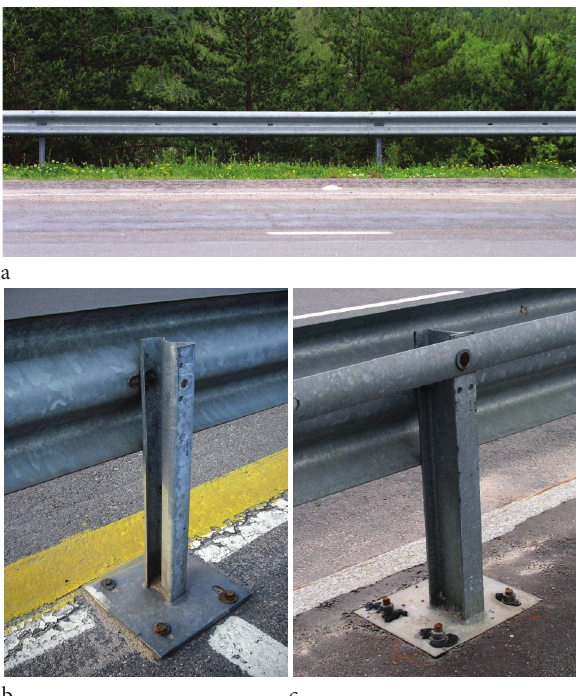
Fig. 1. A metal guardrail: a – a general view of the road (W-shape horizontal beam and posts); b – a Σ-shape post; c – a double T-shape post (Prentkovskis et al.